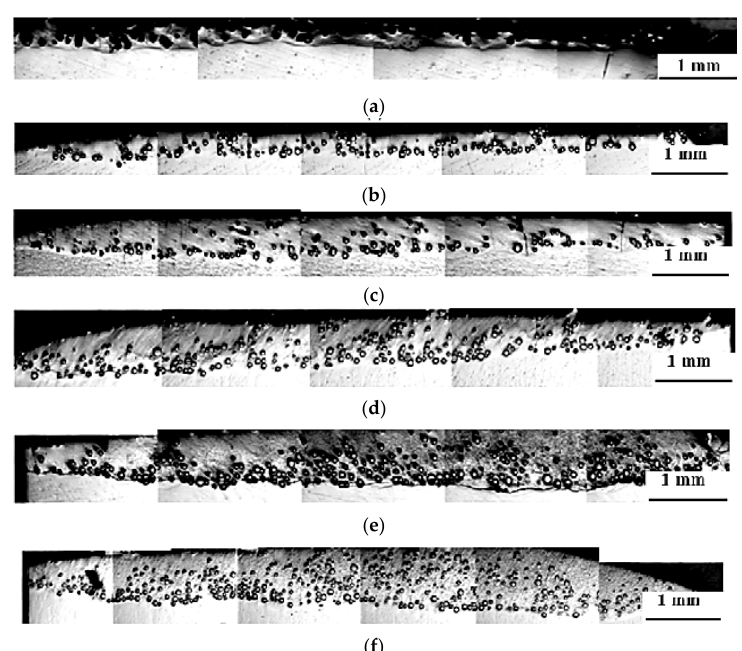
Figure 6. Light micrographs of the cross section (as polished) of the clad layer of Ti-6Al-4V specimens processed at ( a ) 18 J·mm − 2 ; ( b ) 24 J·mm − 2 ; ( c ) 30 J·mm − 2 ; ( d ) 35.71 J·mm − 2 ; ( e ) 47.62 J·mm − 2 ; and ( f ) 59.5 J·mm − 2 . Materials 2017 , 10 , 1178